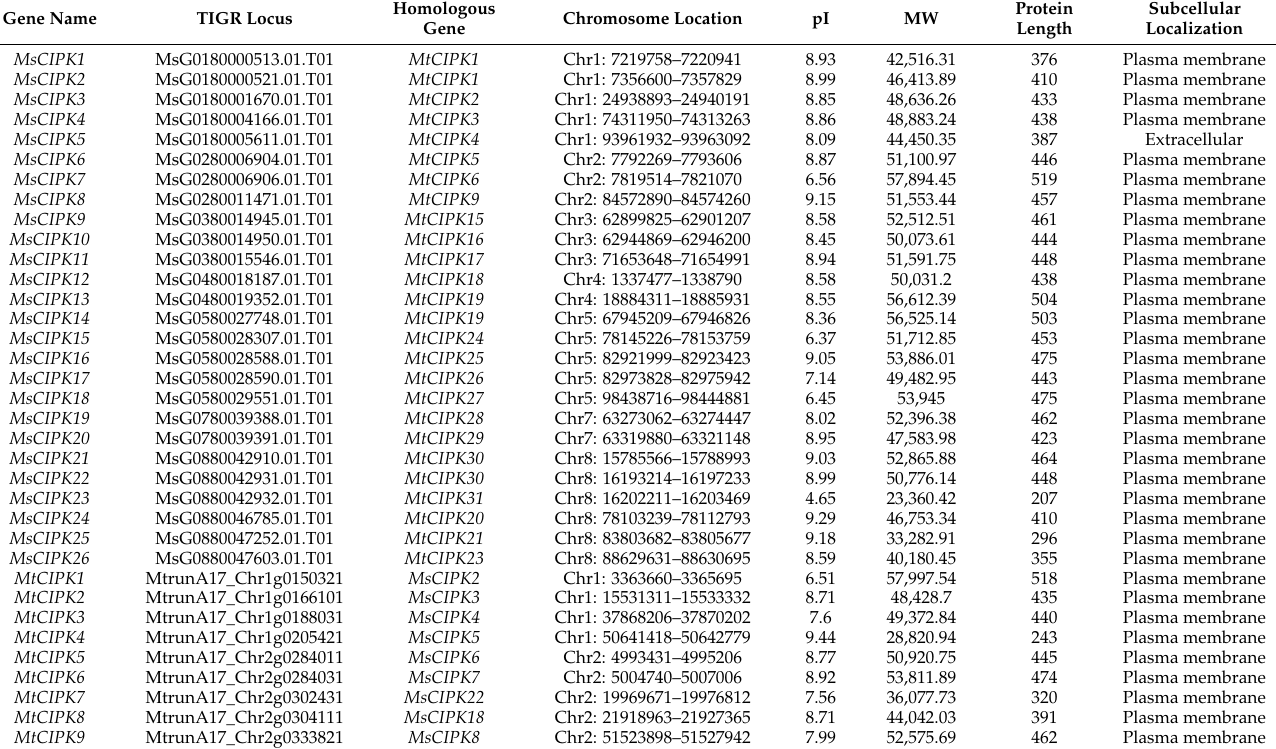
Table 2. Properties of the predicted CIPK proteins in M. sativa and M.